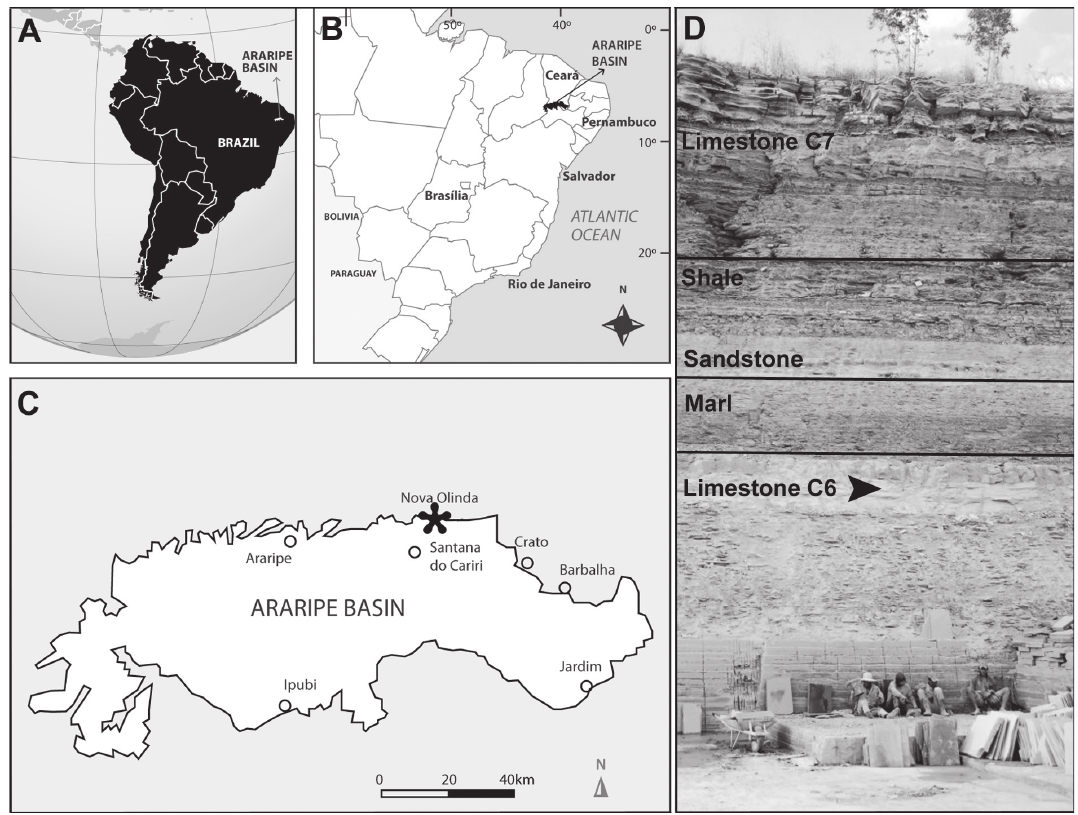
Figure 1 - A. Location of Araripe Basin in South America. B. The Araripe Basin bordering the states of Ceará, Piauí and Pernambuco in northeastern Brazil. C. Outline of the Araripe Plateau, indicating the approximate location of the quarry called “Mina Idemar” in Nova Olinda city, Ceará. D. Crato Formation layering at “Mina Idemar”, indicating the laminated limestone C6-level (according to Neumann and Cabrera 1999) where the specimen was collected. Map modified from Sayão et al.